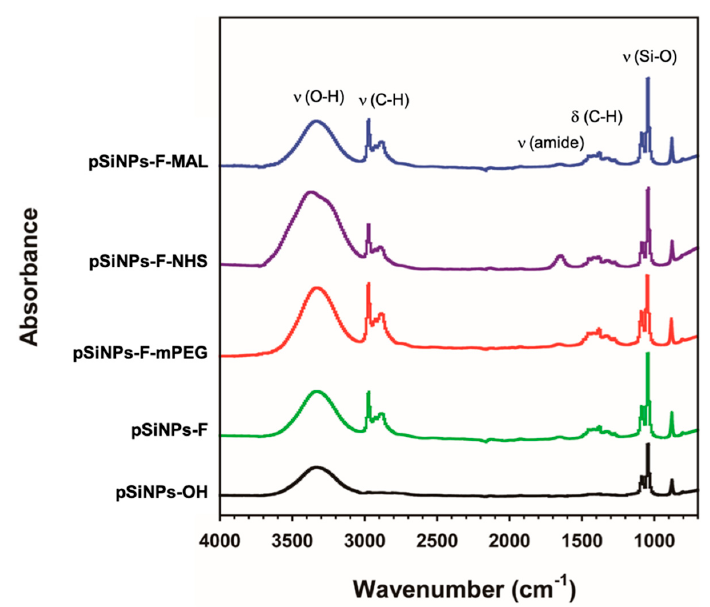
Figure 3. Transmission electron microscopy (TEM) images of oxidized pSiNPs ( pSiNPs-OH ) and its surface-functionalized samples. Scale bar is indicated in each figure.